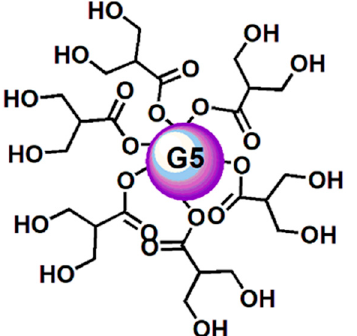
Figure 2. Simplified and intuitive representation of the structure of the dendrimer ( 4 ) having in reality a fifth-generation polyester-based inner matrix based on the tree-like repetition of units of the 2,2- bis (hydroxymethyl) propionic acid and 64 peripheral hydroxyl groups. The image shows only a partial number of the real hydroxyl groups and an inner sphere to facilitate the drawing and for reasons of space. This way to represent dendrimer 4 was previously used and accepted as valid [57].